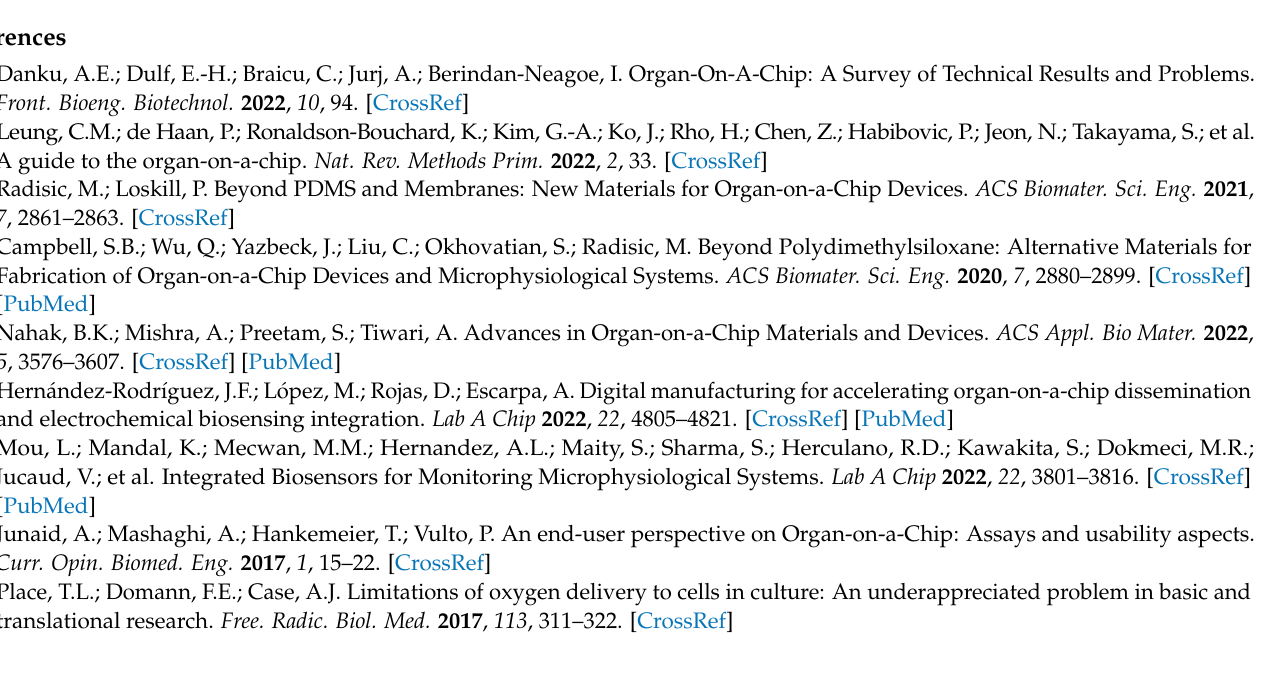
Section S2: Transmission light imaging of adherent cells on commercial PMP film without polishing, ivluding Figure S2: Commercial PMP film and Figure S3: Transmission light images of cells grown on unpolished PMP film. Section S3 with Figure S4: Raw data from monitoring of oxygen concentration. Section S4: Delivery of oxygen to cells in culture, including Equations (1) and (2) and Figure S5: Schematic illustration with input parameters. Ref. [40] is cited in Supplementary